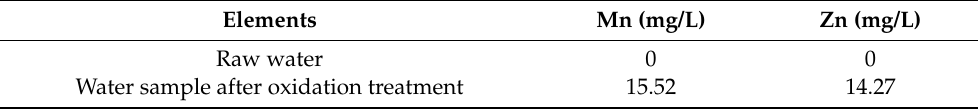
Table 4. The content of metallic elements in water sample.